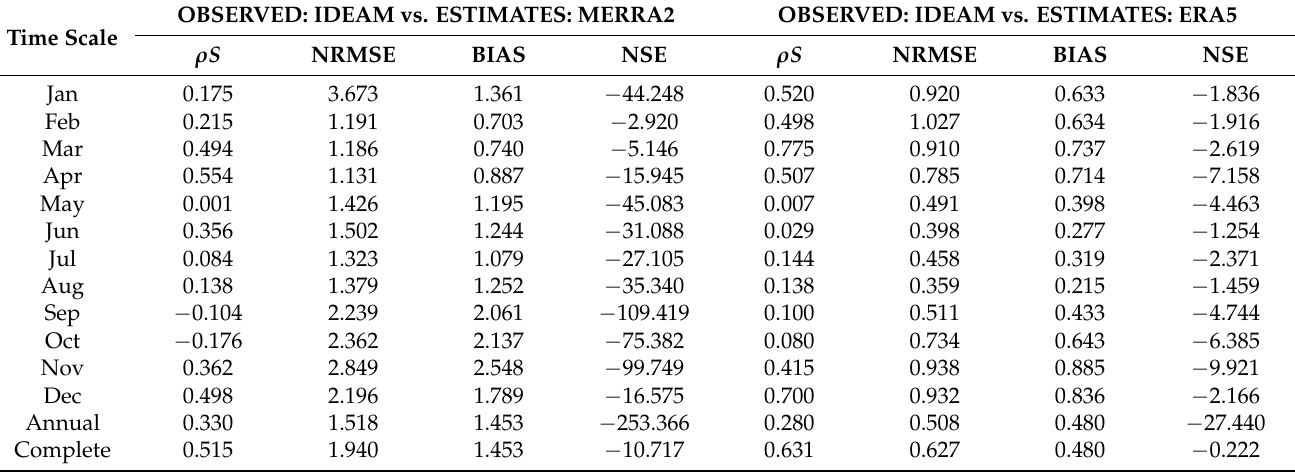
Table 3. Performance results for the tested reanalysis products for average areal rainfall estimations in the Middle Sin ú River basin for 1985–2019.